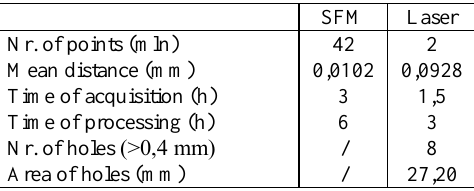
Table 2. Comparison between point clouds